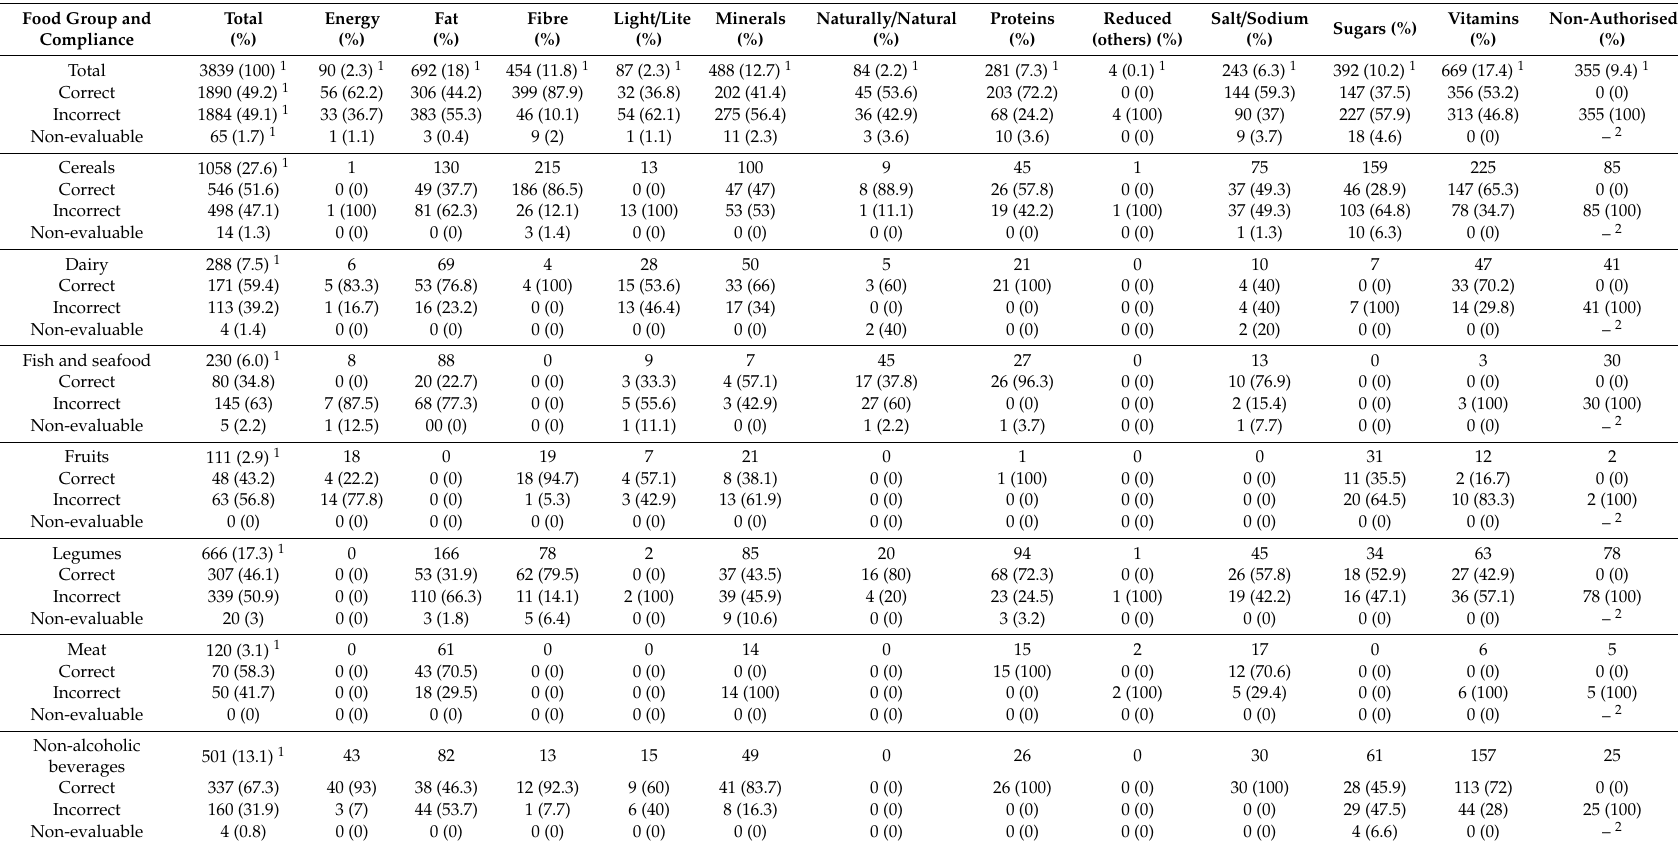
Table 2. Number of NCs and compliance by group and